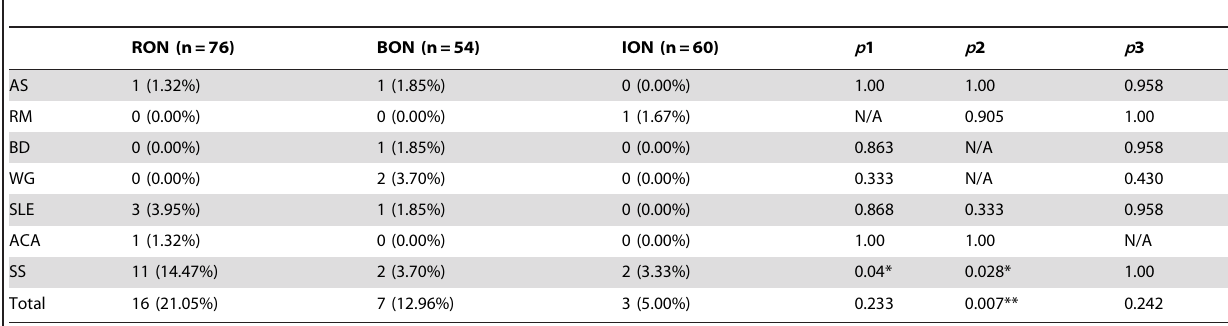
Table 3. Diagnosis of different rheumatologic